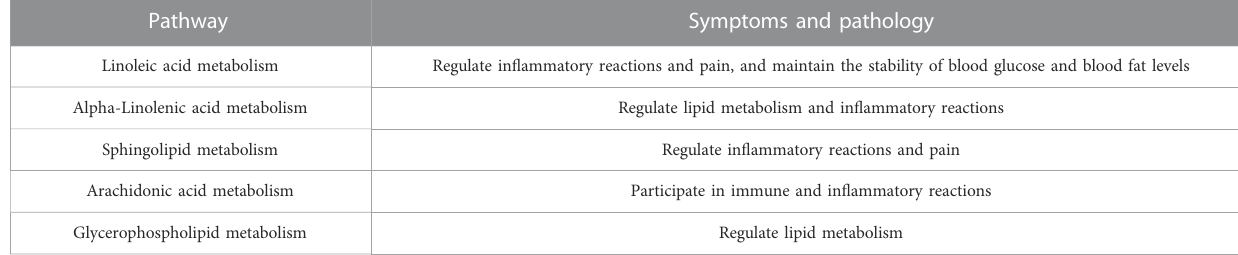
TABLE 5 The relevance of metabolic pathways to symptoms and